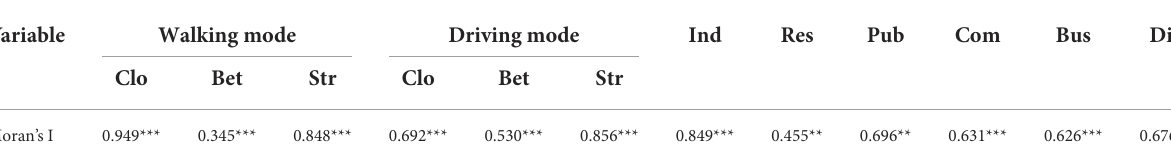
TABLE 3 Spatial correlation test results of variables.